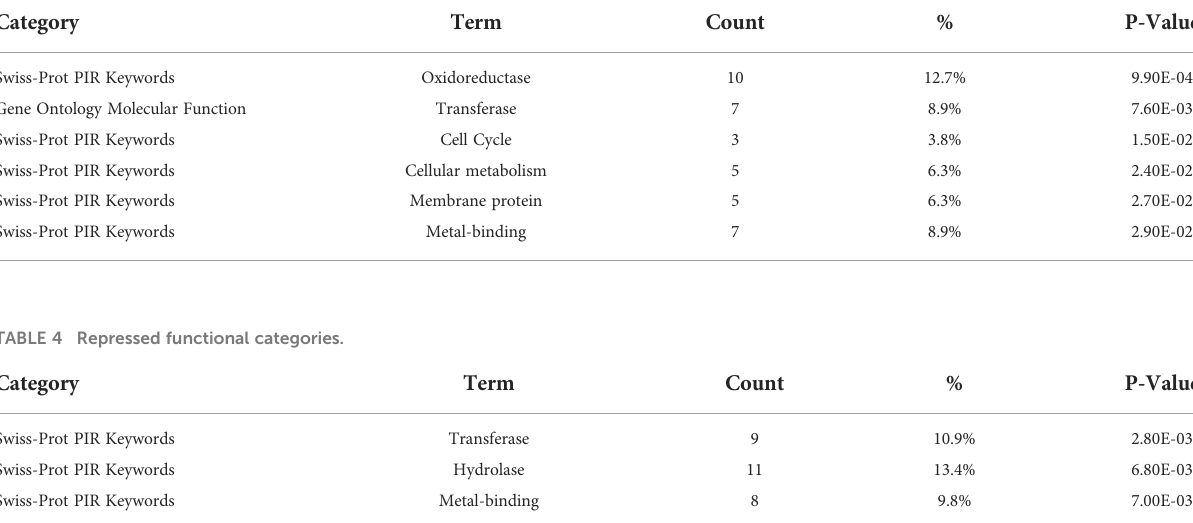
TABLE 3 Induced functional categories.